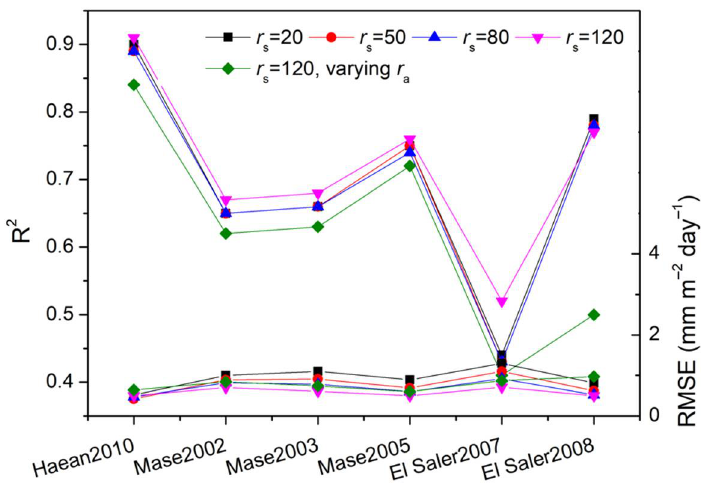
Figure 2. Multi-site evaluations of the FAO-56PM model of the pixel-based RS-PM model with the constant aerodynamic resistance ( r a ) of 208.0/WS for varying bulk surface resistances values ( r s ), ranging from 20, 50, and 80 to 120 s m –1 and varying r a values with a constant r s value of 120 s m –1 in the Haean in South Korea in 2010, Mase in Japan from 2002 to 2005, and El Saler-Sueca in Spain from 2007 to 2008. R 2 : the determination coefficient; RMSE: the root mean square error (mm m –2 day – 1 ); WS : wind speed (m s −1 ). (mm m − 2 day − 1 ); WS : wind speed (m s − 1